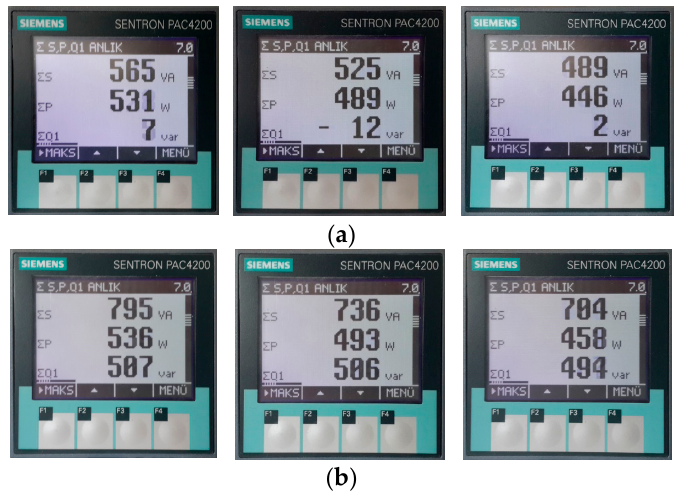
Figure 16. Field records of energy analyzer. ( a ) Q set = 0, and ( b ) Q set = 500 VAr.